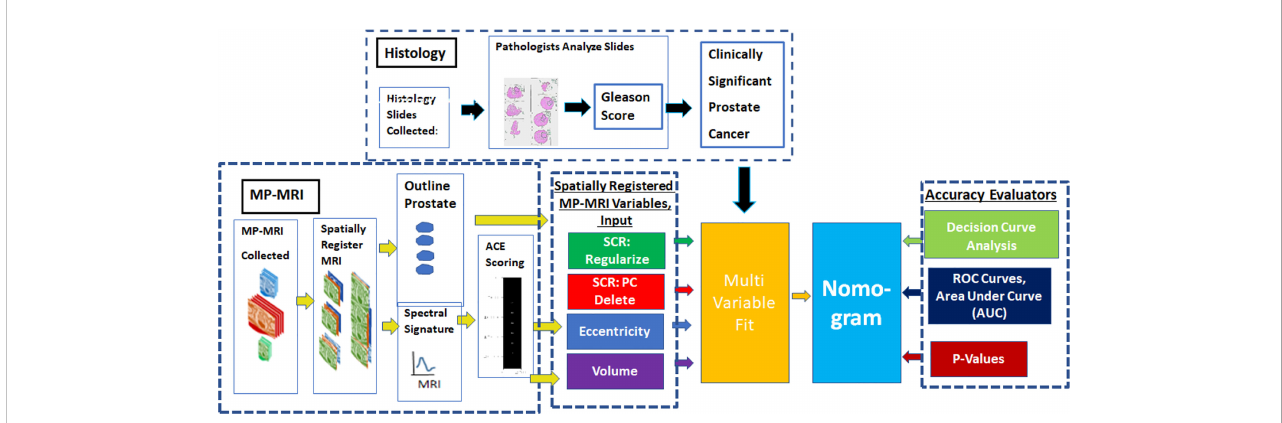
FIGURE 1 provides an overview of the methodology to generate a nomogram from metrics derived from spatially registered MP-MRI (25 – 30) along with accompanying performance evaluations. The main components in the summary are described in greater detail below. The independent variable for the multivariable fi t originates from spatially registered MP-MRI and the dependent categorical variable Clinically Signi fi cant Prostate Cancer derived from Gleason score and pathology exam of histology of the resected